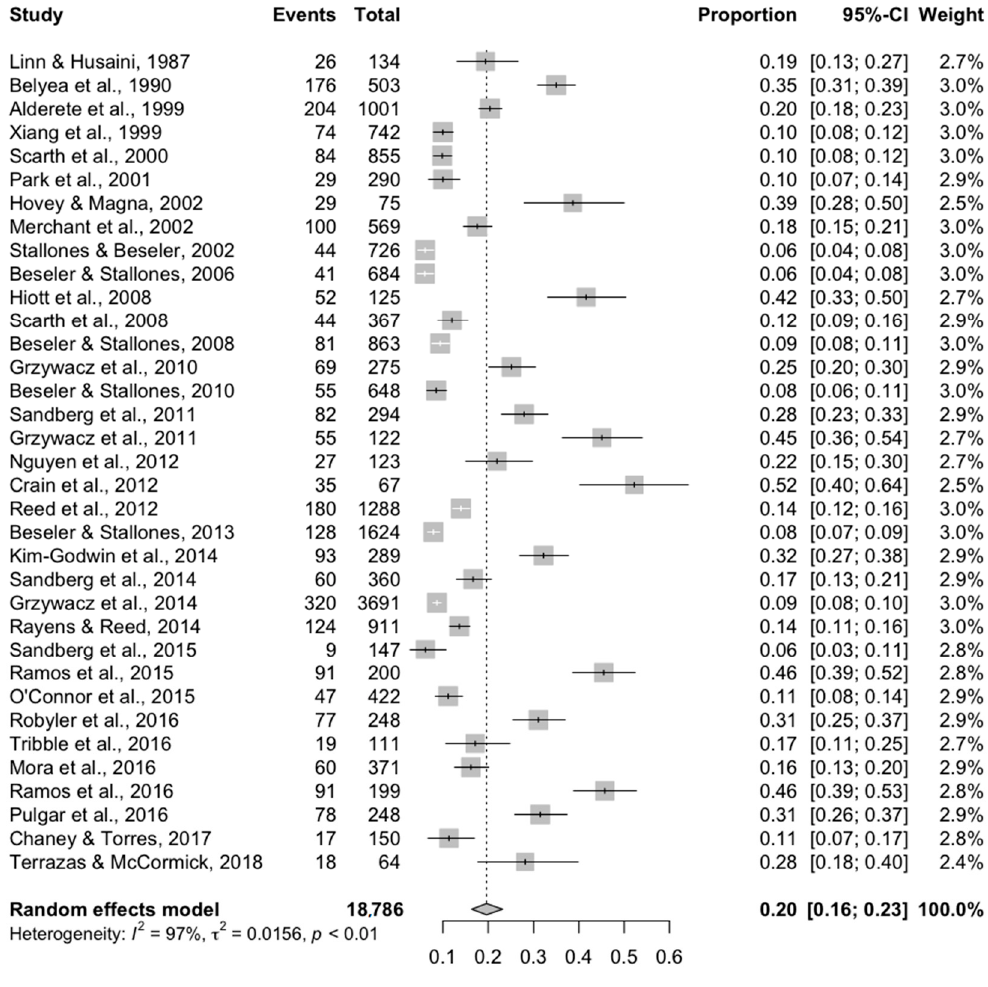
Figure 2. Overall meta-analysis for the 35 studies conducted in the United States reporting a binary outcome (yes/no) using the CES-D/DR scale to measure depression in farming populations.